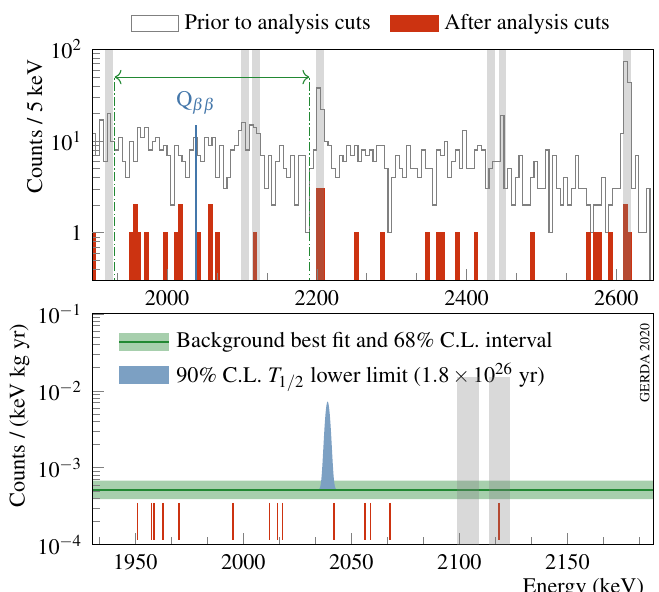
Figure 27. Top panel: enlarged view of the energy distribution of GERDA Phase II events between 1900 and 2650 keV before and after analysis cuts. Bottom panel: result of the unbinned extended likelihood fit: The blue peak displays the expected 0 νββ decay signal for T 0 ν of 1.8 10 26 yr. Vertical lines represent the events in the analysis window after ·